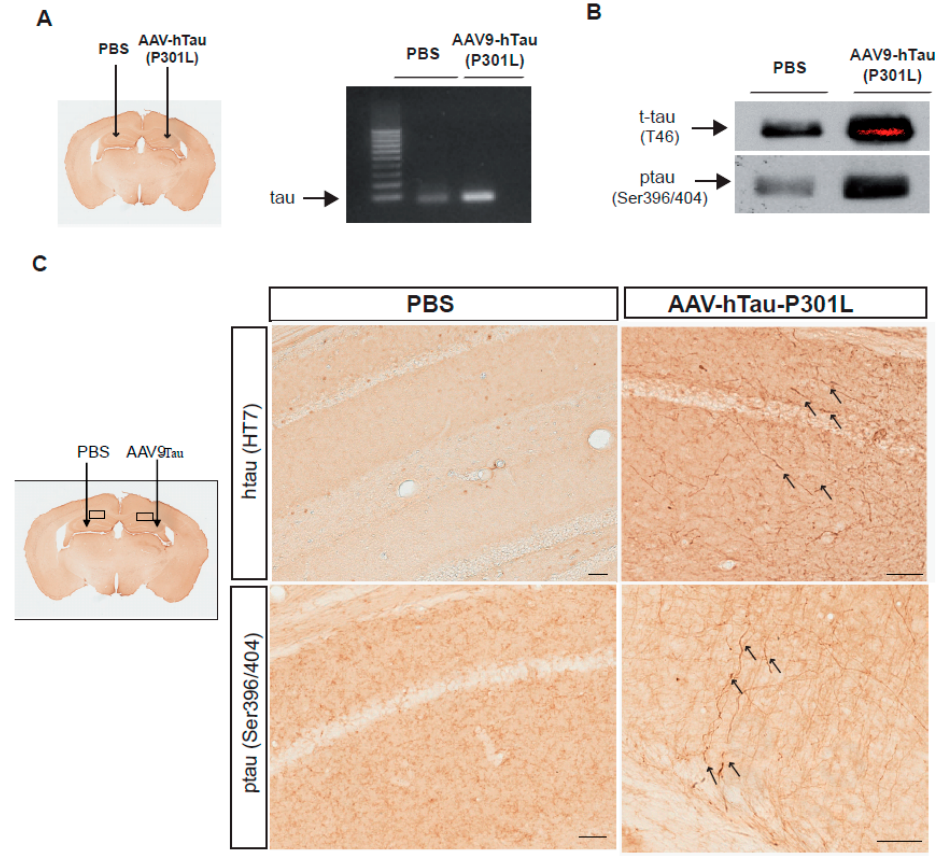
Figure 1. Overexpression of tau was detected in the AAV9-hP301LTau-injected hippocampus in comparison to PBS-injected side. Wild type (WT) mice were injected unilaterally with PBS or AAV9-hTauP301L in the hippocampus and analyzed 1 month later. ( A ) Polyacrylamide-gel analysis of the RT-PCR amplification of human tau transcript extracted from the hippocampus injected with PBS or with AAV9-hP301LTau. ( B ) Representative western blots of total tau (t-tau, using T46 antibody) and phospho-tau (ptau, Ser396/404, using PHF1 antibody) showing protein bands from hippocampus injected with PBS or AAV9-hTauP301LTau. ( C ) Representative images showing human tau and ptau (Ser396/404) immunoreactivity using HT7 and PHF1 antibodies in PBS- and in AAV9-hTauP301L- injected hippocampi (scale bar = 50 µ